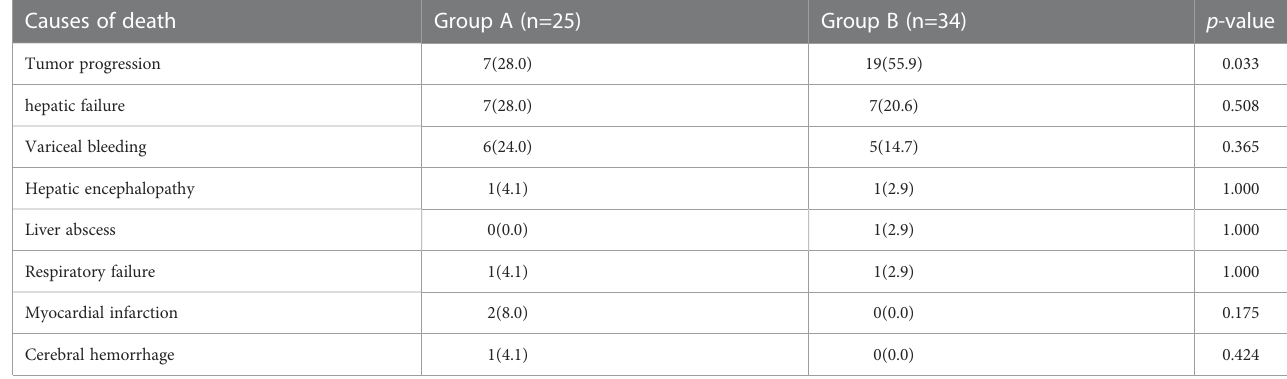
TABLE 3 The causes of death in 2 groups. Causes of